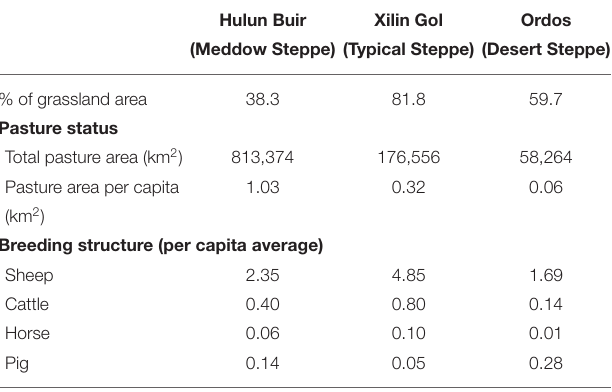
TABLE 8 | Production patterns of rural residents under existent natural resources (2012).